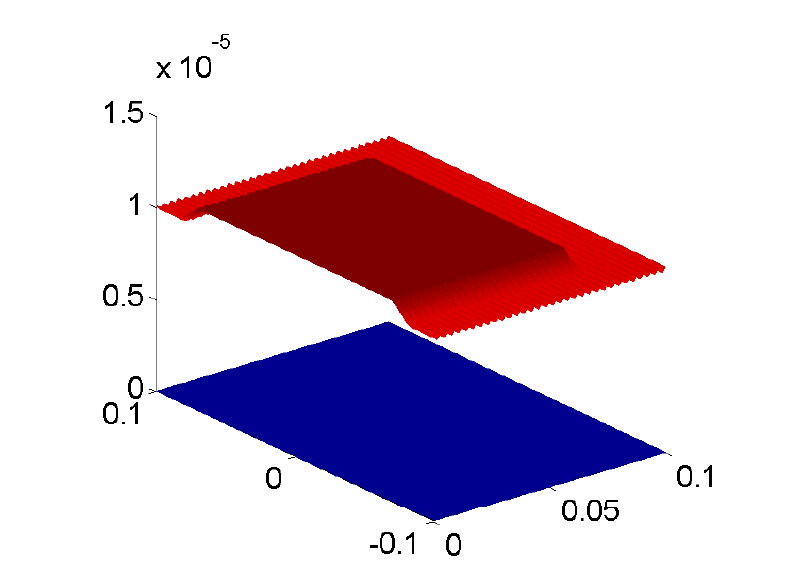
Figure 1. Geometry of a pocket bearing with surface roughness